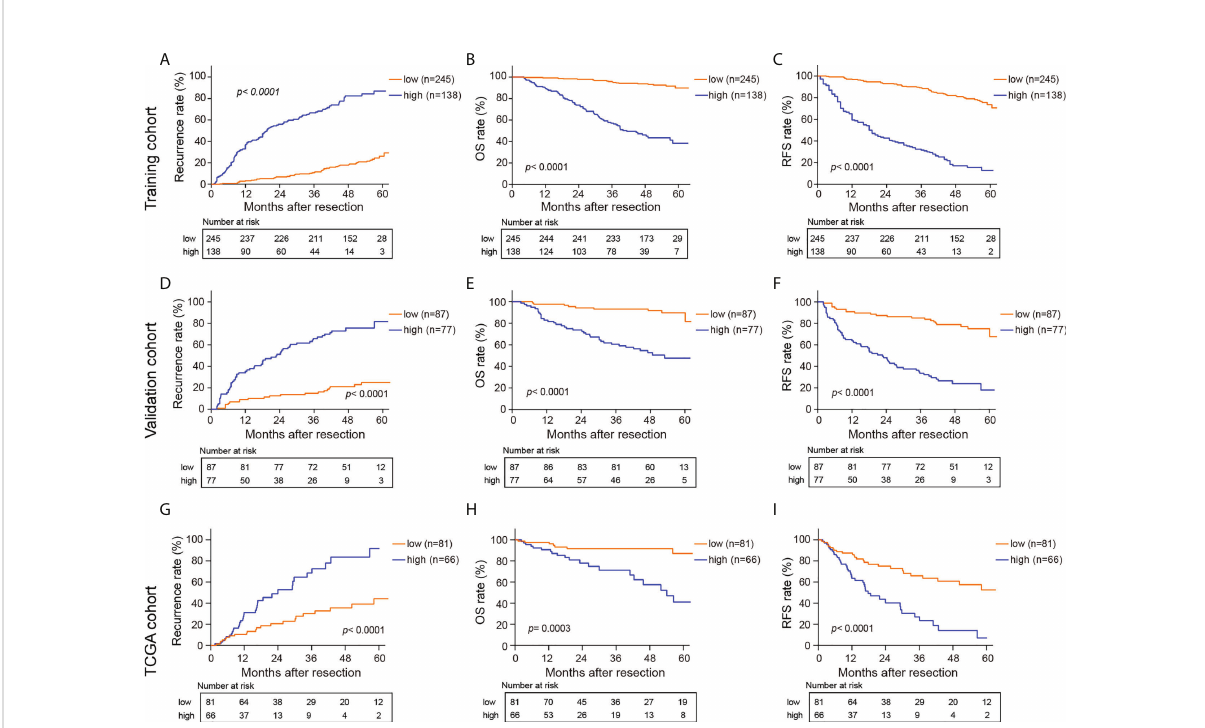
FIGURE 4 Kaplan-Meier curves for recurrence rate, OS, and RFS in the training (A – C) , validation (D – F) and TCGA cohorts (G – I) based on HS. HS, histological score; OS, overall survival; RFS, recurrence free